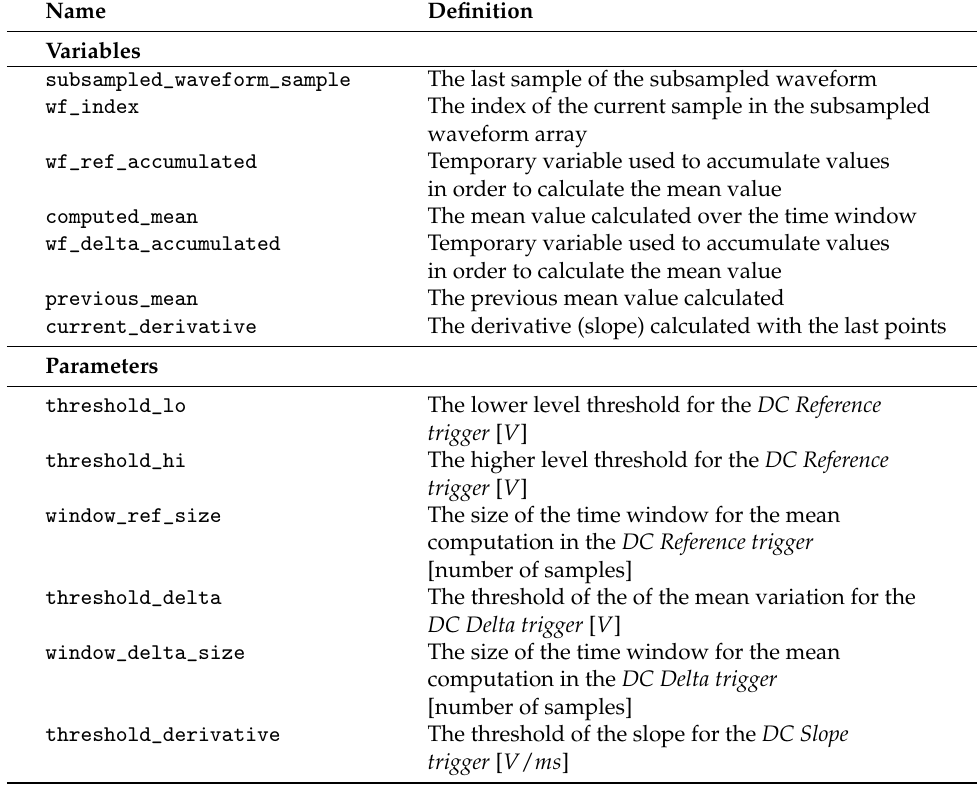
Table 1. Algorithm variables and